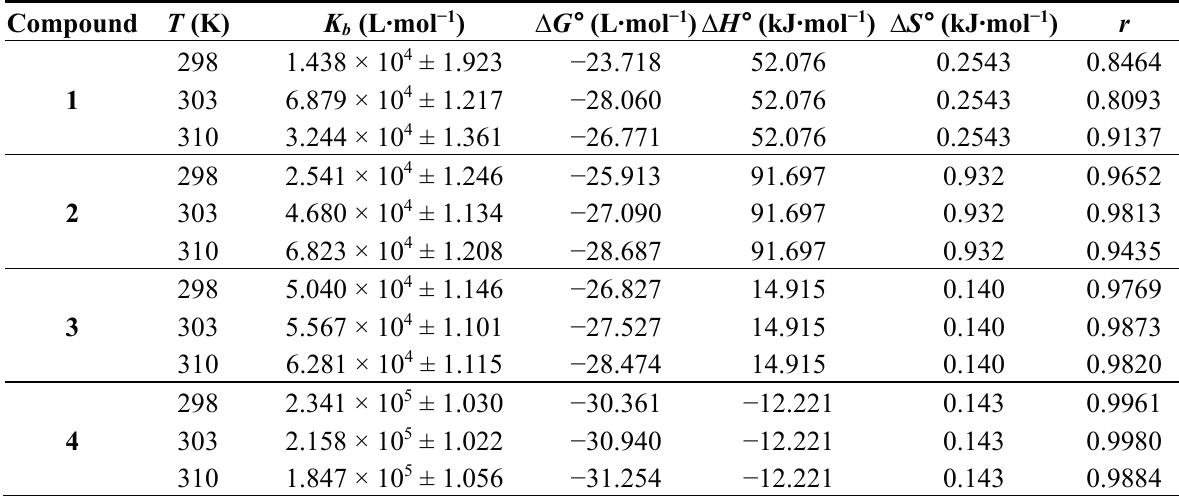
Table 2 Binding constants and thermodynamic parameters of the interaction between compounds 1 – 4 and BSA at different